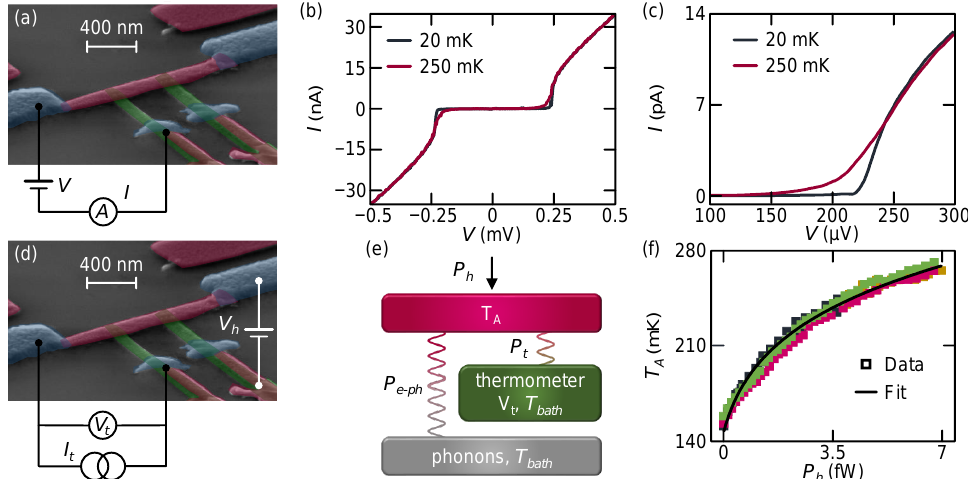
Figure 4. Energy gap and thermal properties of the nano-sensor active region. ( a ) False-color scanning electron micrograph of a typical auxiliary device. The core of the device is made of an Al/Cu bilayer nanowire (purple) sandwiched between two Al leads (blue). To perform tunnel spectroscopy a voltage ( V ) is applied between A and an Al tunnel probe (green) while recording the current ( I ). ( b ) Tunneling current ( I ) versus voltage ( V ) characteristics recorded at T bath = 20 mK (blue) and T bath = 250 mK (purple). ( c ) Zoom of the IV characteristics in correspondence of the transition to the normal-state. It is possible to extract ∆ A ,0 (cid:39) 23 µ eV and ∆ P ,0 (cid:39) 200 µ eV. ( d ) Schematic representation of the set up employed for the thermal measurements. The left tunnel junction serving as thermometer is biased with a constant current ( I t ) while the voltage ( V t ) is measured. The right junction is voltage biased ( V h ) and operated as local electronic heater. ( e ) Thermal model describing the main heat exchange mechanisms involved in the experiment. The power injected by the local heater ( P h ) relaxes by the exchange with phonons ( P e - ph ) and outflows through the thermometer tunnel junction ( P t ). ( f ) Electronic temperature of the active region ( T A ) versus the injected power by the heater ( P h ). The dots represent 5 different sets of measurements, while the back line depicts the fit performed by employing Equation